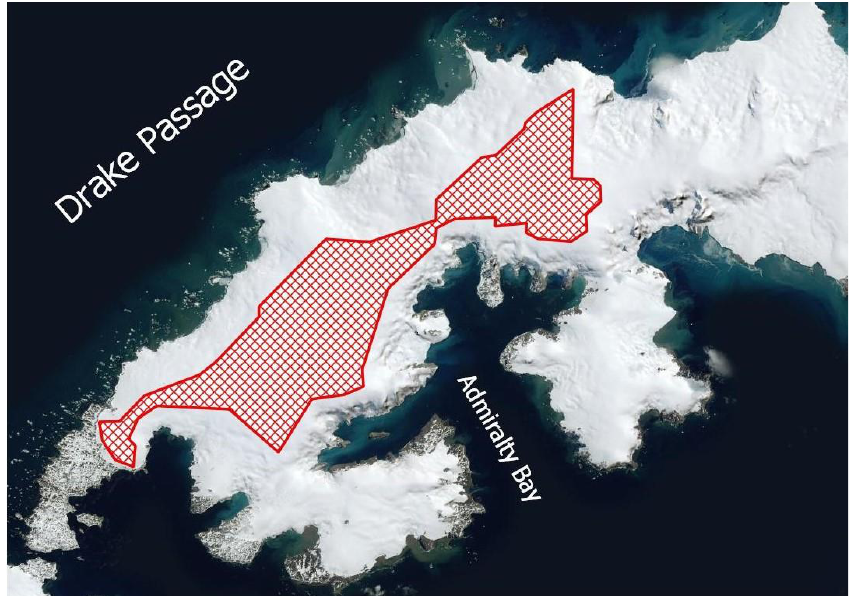
Figure 17. Area in which GPR fieldwork was performed from 1997 – 2007, adapted with permission from Blindow et al. [87] published by Cambridge University Press, 2010.